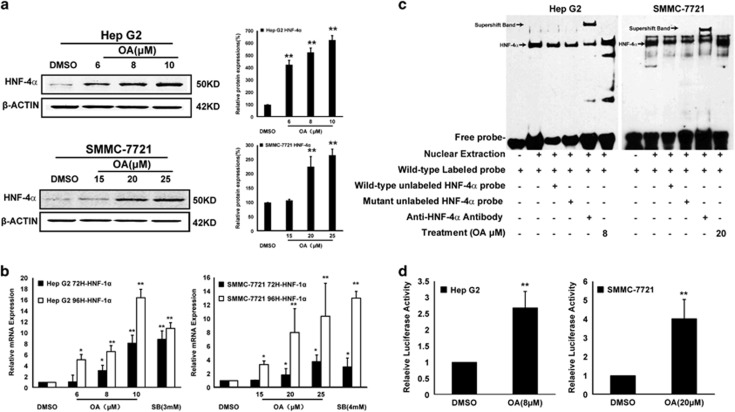
OA promotes the expression of HNF-4α and its binding to the promoter region of HNF-1α. (a) The whole-cell lysates were subjected to WB of HNF-4α. (b) Real-time quantitative PCR of HNF-1α. (c) EMSA and dual-luciferin reporter system assay. The outcome of dual-luciferin reporter system assay was presented by bar chart. Bars, SD. *P<0.05 or **P<0.01 versus DMSO-treated l cells